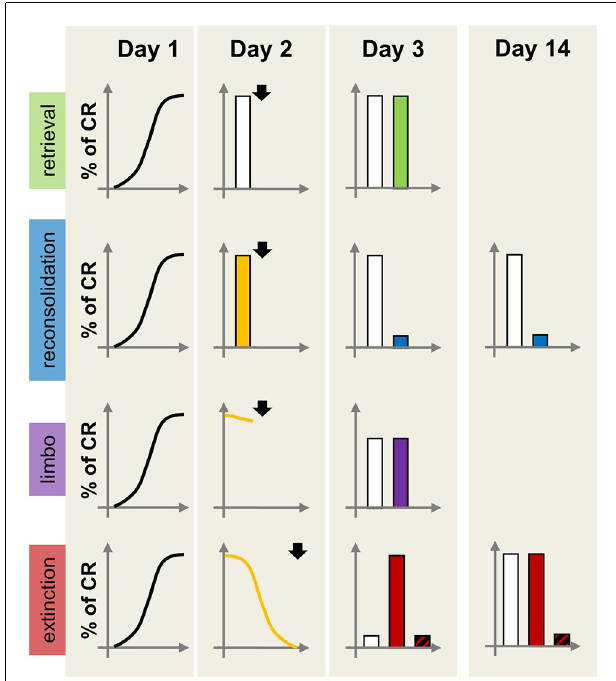
FIGURE 2 | Schematic representation of the effects of amnestic or hypermnestic manipulations on memory persistence as a function of the dominant memory process. On Day 1, all individuals acquire the same pavlovian CR. On Day 2, different groups receive different (increasing) numbers of CS re-exposure producing four experimental conditions: retrieval only (brief CS exposure without prediction error, top row), reconsolidation (brief CS exposure with prediction, second row), limbo (intermediate CS exposure, third row) or extinction (prolonged CS exposure, bottom row). Immediately after each CS re-exposure condition, individuals receive an amnestic or control treatment (e.g., protein synthesis inhibitor; arrowhead). For the extinction condition, the plot also shows the effect of a hypermnestic drug (e.g., D-cycloserine). On Day 3 long-term memory is tested, with outcomes differing depending on the experimental condition. Retrieval condition: the amnestic treatment (green bar) does not affect the CR, indicating that the CS-US memory did not destabilize on Day 2. Reconsolidation condition: the amnestic treatment (blue bar) produces memory disruption, due to the interference of the drug with the CS-US memory re-stabilization process at Day 2. Limbo condition: there is no difference in CR between vehicle- and drug-treated groups (purple bar), indicating that the original CS-US memory was not destabilized at Day 2, and no engagement of extinction mechanisms. Extinction condition: the amnestic-treated group (red bar) shows high CR, consistent with extinction disruption during Day 2; it also shows extinction in the group receiving the hypermnestic drug. On Day 14 the second row shows maintenance of the low CR in animals receiving the amnestic treatment after memory reactivation. By Day 14, the vehicle-treated extinction group shows the spontaneous recovery of the CR, whereas the hypermnestic-treated group (diagonally striped black and red bar) maintains a low CR due to enhanced extinction.